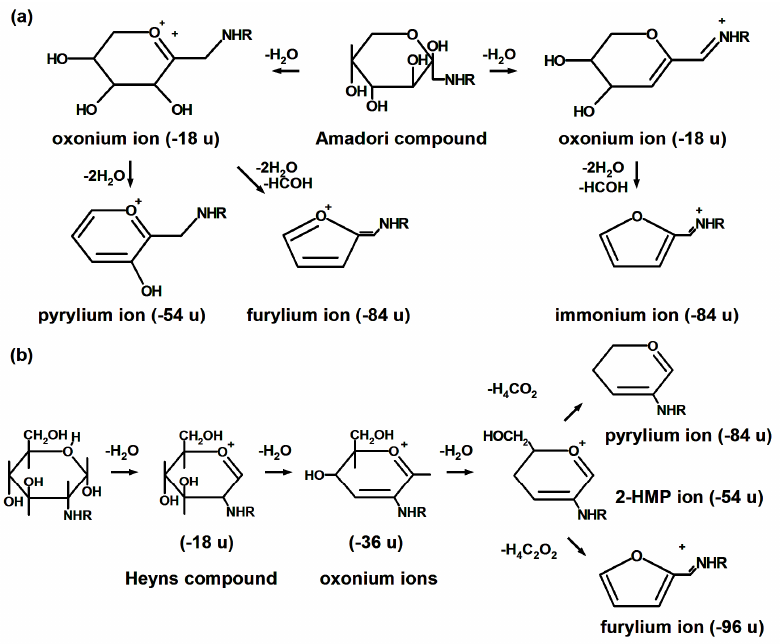
Figure 5. Tandem mass spectrometric (MS/MS) fragmentation patterns of: glucose-derived Amadori ( a ); and fructose-derived Heyns ( b ) peptides, represented by characteristic signals, corresponding to oxonium (-H 2 O and -2H 2 O), pyrylium (-3H 2 O) and furylium/immonium (-3H 2 O-HCHO)